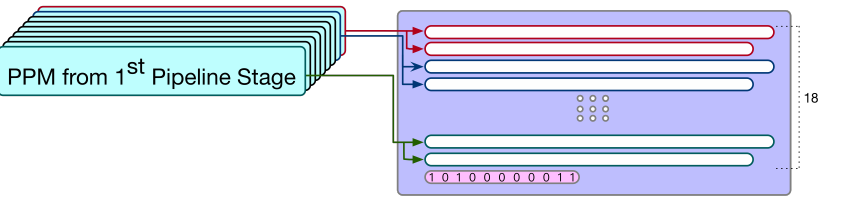
Figure 14. The PPM used in the second pipeline